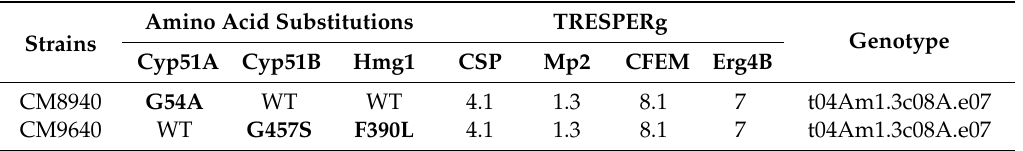
Table 3. Amino acid substitutions in Cyp51A, Cyp51B and Hmg1 and TRESPERg genotype in the two clinical azole-resistant A. fumigatus